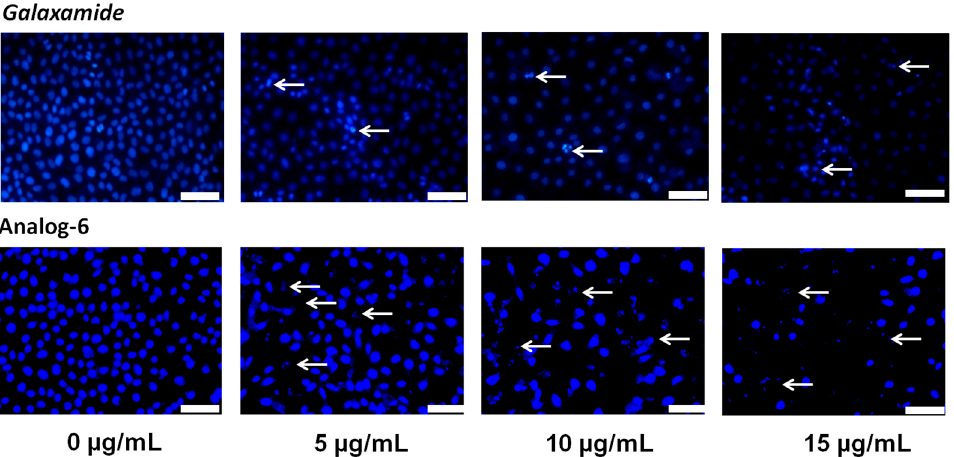
Figure 4. Fluorescent microscope images of HepG 2 cells treated with different concentrations of Galaxamide and Analog-6 after Hoechst 33342 staining. White arrows in the each images indicate the cells with damaged nuclei (chromatin condensation and fragmentation). Scale bar is 50 µm.